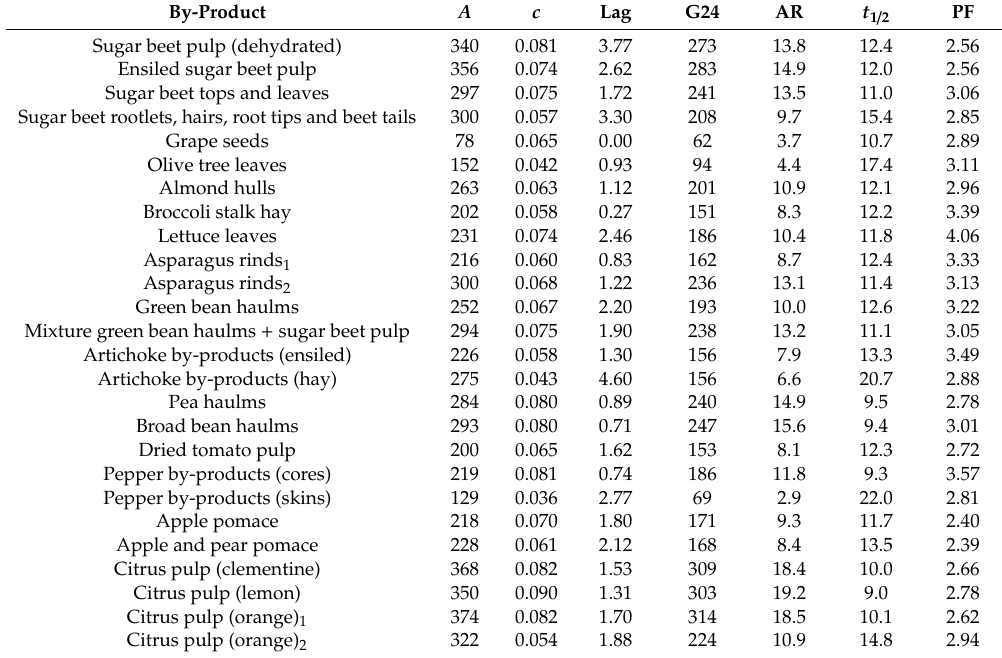
Table 3. Rumen fermentation kinetics estimated from in vitro gas production profiles of the by-products. By-Product A c Lag G24 AR t 1 / 2 PF Sugar beet pulp